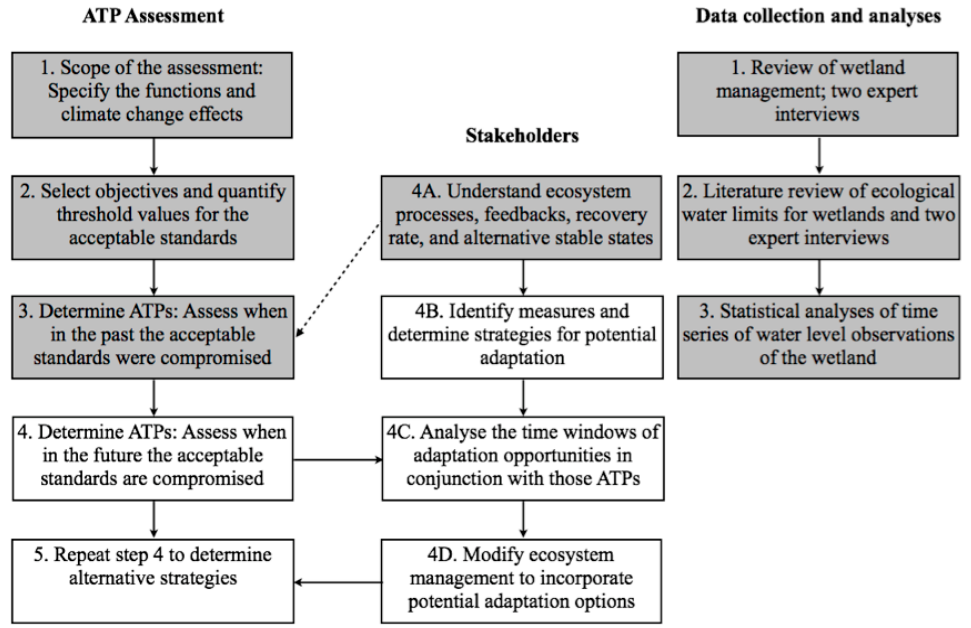
Figure 1. The complete Adaptation Tipping Point (ATP) methodology with an overview of the steps undertaken in this study (indicated with grey boxes), along with the data collection and analyses conducted in this study (Adapted from: [16]).